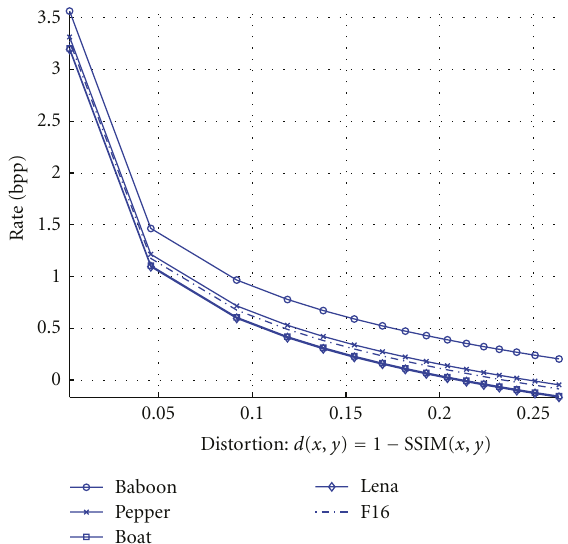
Figure 1: High-resolution RDF under the similarity measure d ( x , y ) = 1 − SSIM( x , y ) for di ff erent images and using an 8 × 8 block size.